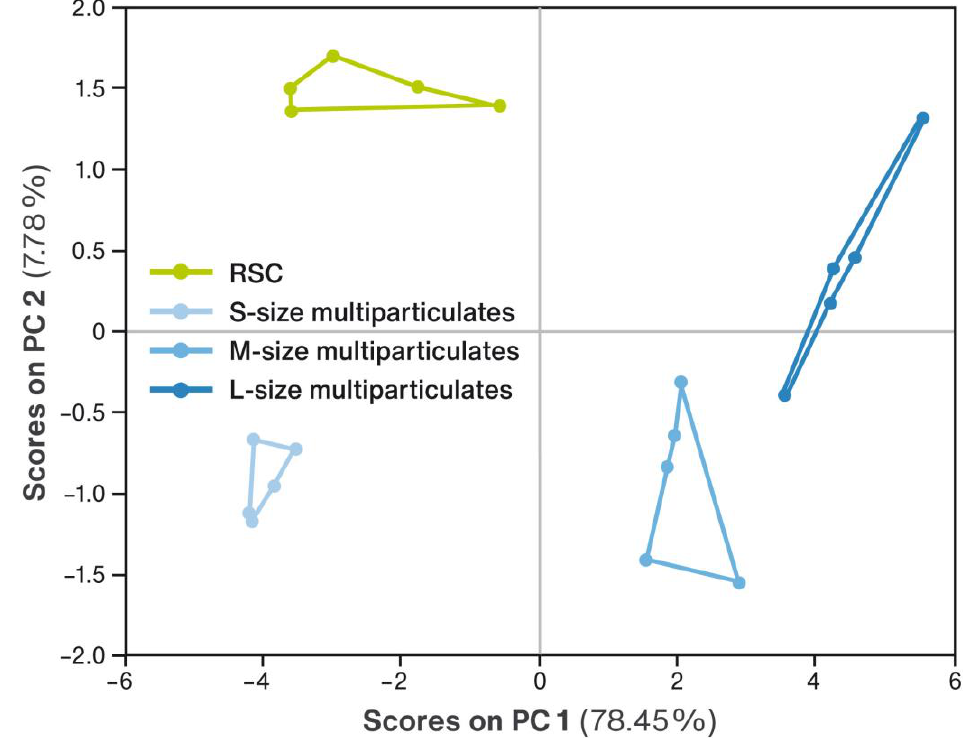
Figure 3. PCA score plot of E-Tongue analysis results for the RSC multiparticulates of each size (S, M, or L), compared to a bitter-tasting reference substance (RSC).